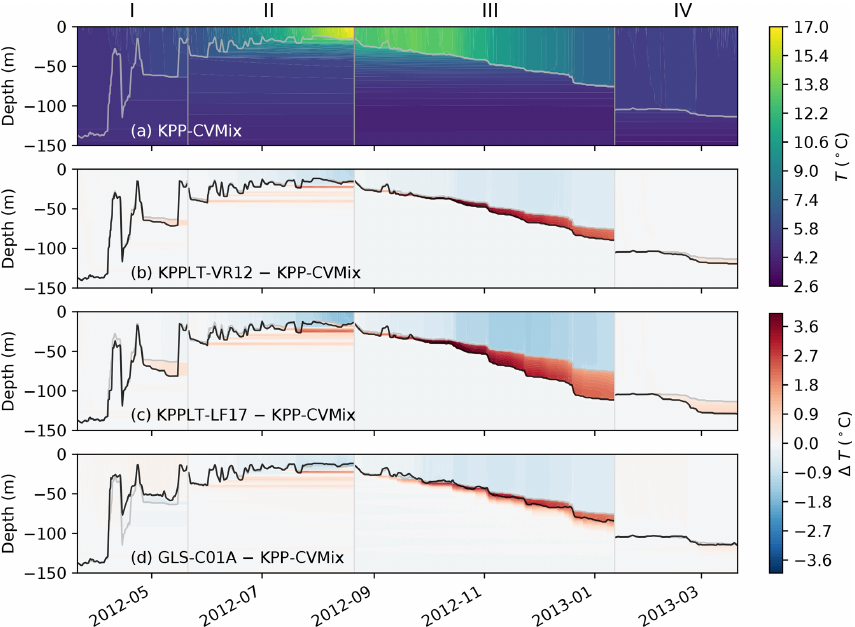
Figure 6. Hovmöller diagrams comparing the simulated temperature between the four vertical mixing schemes at Ocean Station Papa. Panel (a) shows the simulated temperature in KPP-CVMix. Panels (b) – (d) show the differences from KPP-CVMix in KPPLT-VR12, KPPLT- LF17, and GLS-C01A, with the black line showing the MLD. In all panels, the gray line shows the MLD in KPP-CVMix as a reference. KPP-CVMix is used as the reference here simply for better visualization of the effects of Langmuir turbulence parameterizations (b, c) .